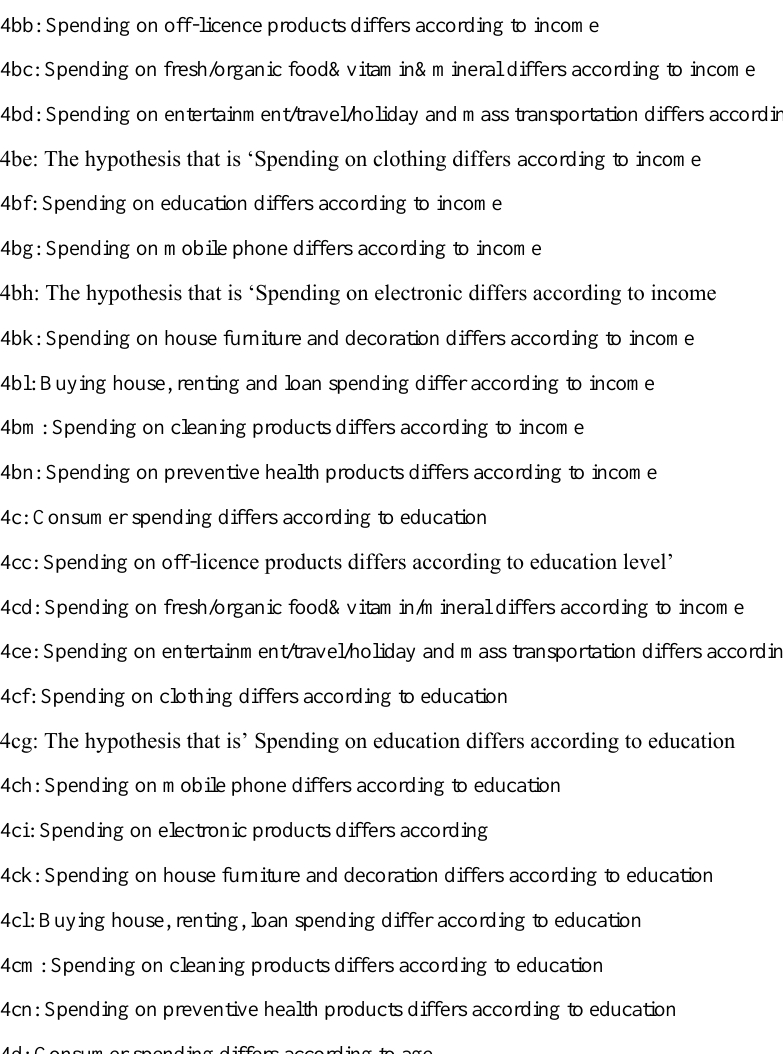
H4ak: Spending on home furniture and decoration differs according to gender H4al: Spending on buying house, renting and loan differs according to gender H4b: Consumer spending differs according to income H4bb: Spending on off-licence products differs according to income H4bc: Spending on fresh/organic food&vitamin&mineral differs according to income H4bd: Spending on entertainment/travel/holiday and mass transportation differs according to income H4be: The hypothesis that is ‘Spending on clothing differs according to income H4bf: Spending on education differs according to income H4bg: Spending on mobile phone differs according to income H4bh: The hypothesis that is ‘Spending on electronic differs according to income H4bk: Spending on house furniture and decoration differs according to income H4bl: Buying house, renting and loan spending differ according to income H4bm: Spending on cleaning products differs according to income H4bn: Spending on preventive health products differs according to income H4c: Consumer spending differs according to education H4cc: Spending on off-licence products differs according to education level’ H4cd: Spending on fresh/organic food&vitamin/mineral differs according to income H4ce: Spending on entertainment/travel/holiday and mass transportation differs according to education H4cf: Spending on clothing differs according to education H4cg: The hypothesis that is’ Spending on education differs according to education H4ch: Spending on mobile phone differs according to education H4ci: Spending on electronic products differs according H4ck: Spending on house furniture and decoration differs according to education H4cl: Buying house, renting, loan spending differ according to education H4cm: Spending on cleaning products differs according to education H4cn: Spending on preventive health products differs according to education H4d: Consumer spending differs according to age H4dd: Spending on off-license products differs according to age H4de: Spending on fresh, organic food, vitamin and mineral differs according to age H4df: Spending on entertainment/travel/holiday and mass transportation differs according to age H4dg: Spending on clothing differs according to age H4dh: Spending on education differs according to age H4di: Spending on mobile phone differs according to age H4dk: Spending on electronic differs according to age H4dm: Buying house, renting, loan spending differ according to age H4dn: Spending on cleaning products differs according to age H4dp: Spending on preventive health products differs according to age H5: Consumer savings differ according to demographic H5a: Consumer savings differ according to